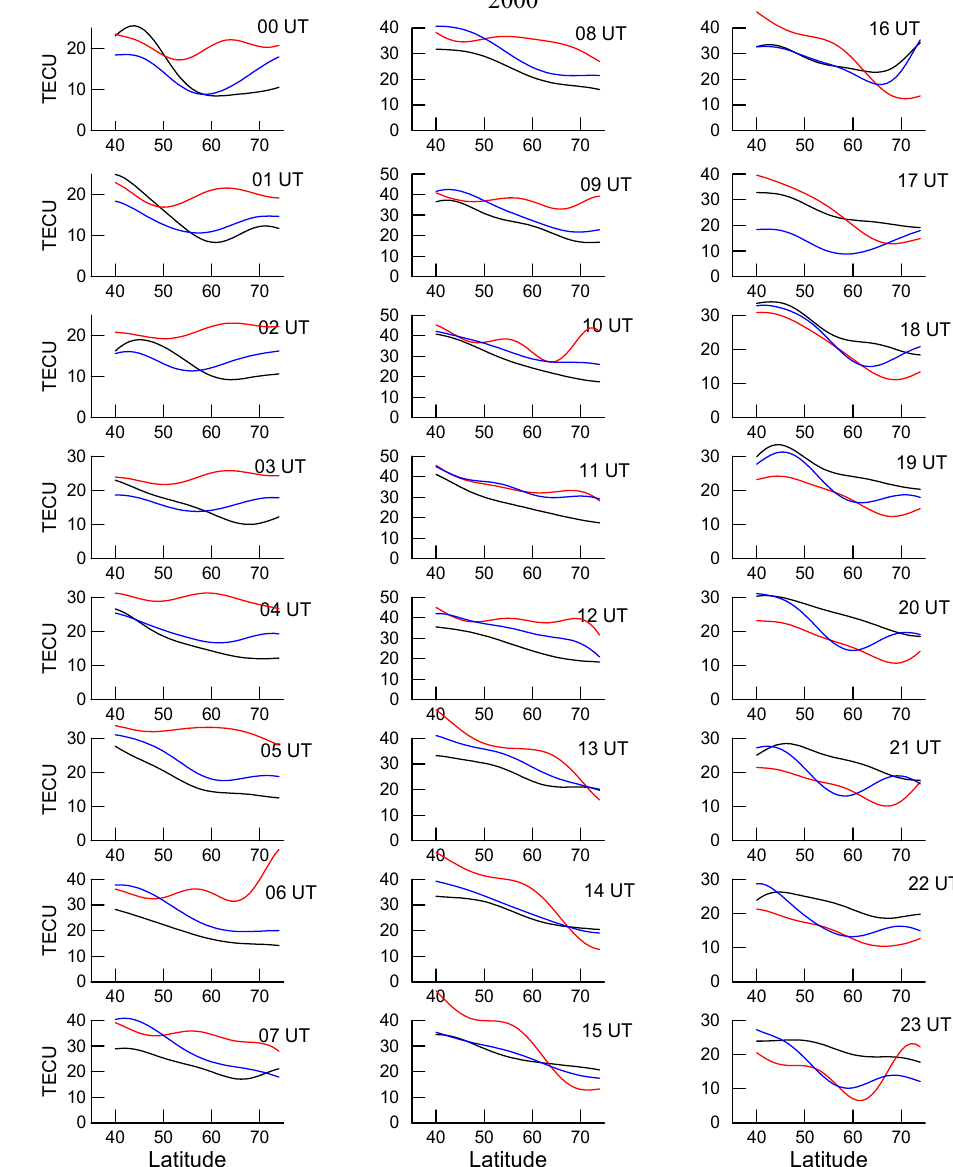
Fig. 6 Latitudinal TEC profiles over Europe at longitude 20o E. Black line – 12 July, ∑ Kp=16, Fig. 6. Latitudinal TEC profiles over Europe at longitude 20 ◦ E. Black line – 12 July, P K p = 16, red line – 13 July , P K p = 30, red line – 13 July, ∑ Kp=30, blue line – 14 July, ∑ Kp=36. blue line – 14 July, P K p =